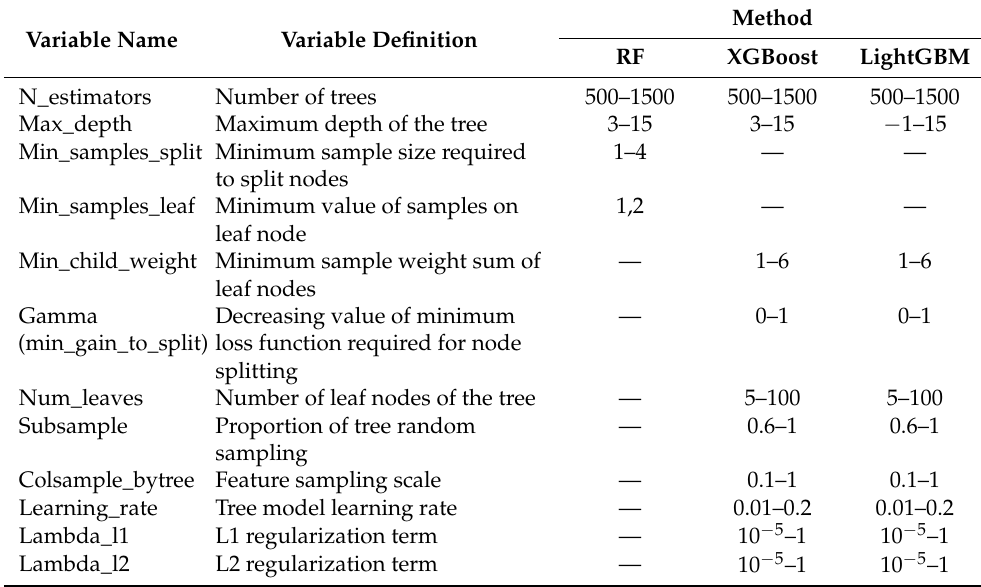
Table A2. Hyperparametric variables of machine learning algorithm models (RF, XGBoost, LightGBM) and its grid search range.